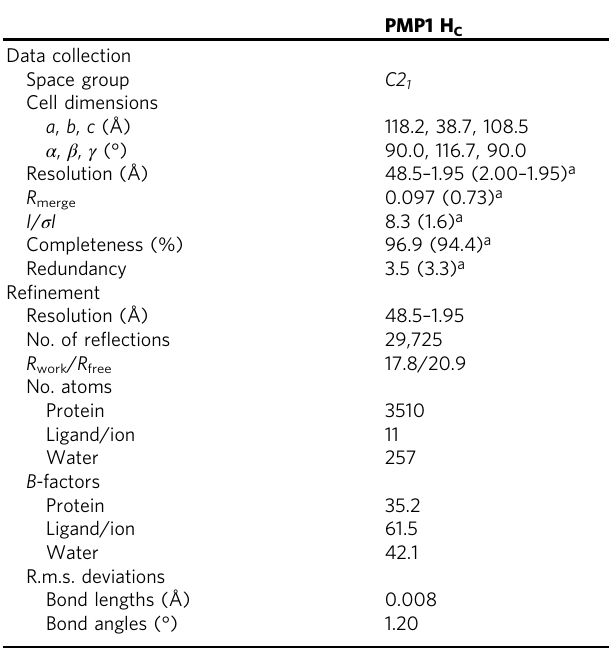
Table 2 Data collection and re fi nement statistics (molecular